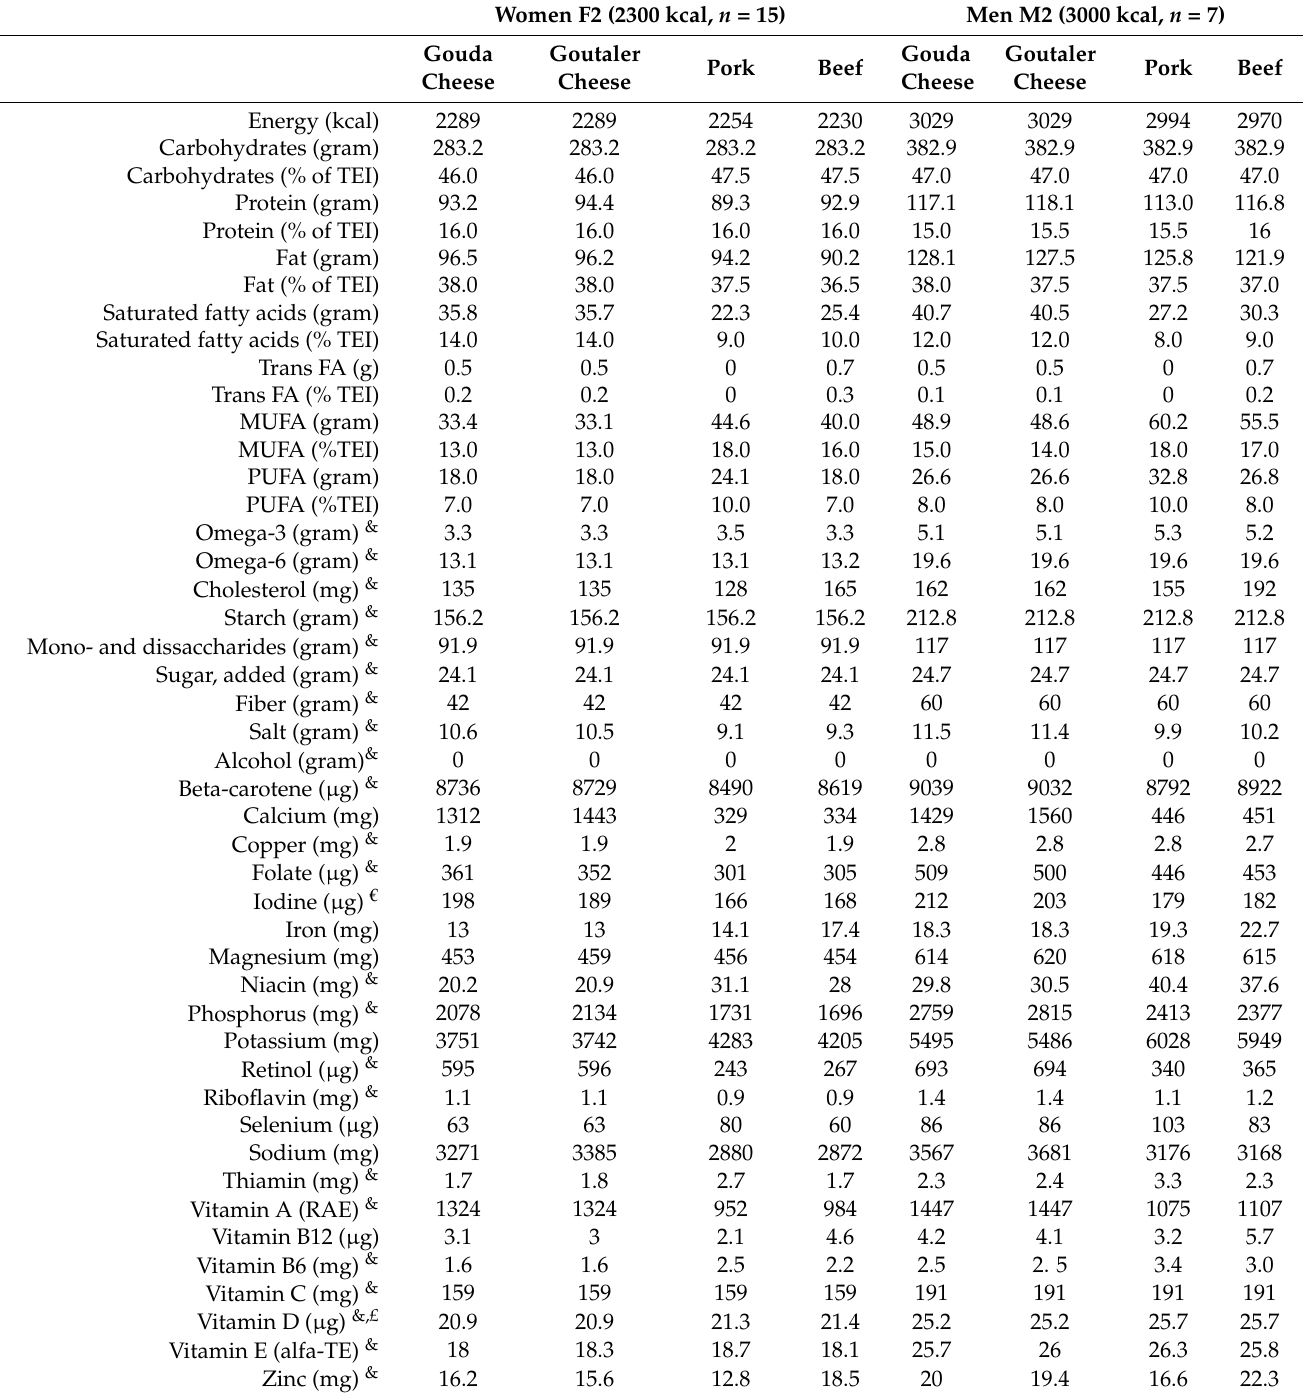
Table 2. Test diet composition according to groups F2 (women, 2300 kcal, n = 15) and M2 (men, 3000 kcal, n =